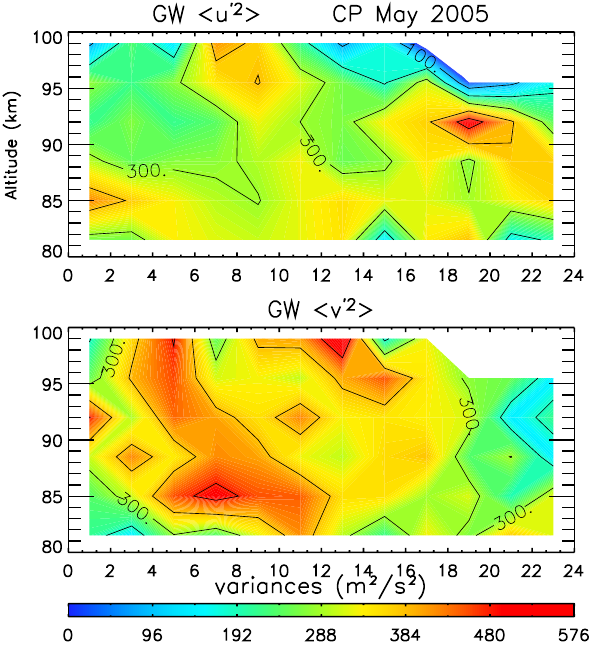
Fig. 21. Zonal (top) and meridional (bottom) wind variances for May 2005 over Cachoeira Paulista (23 ◦ S, 45 ◦ W) using MCD anal- ysis removing the tidal apparent variances.